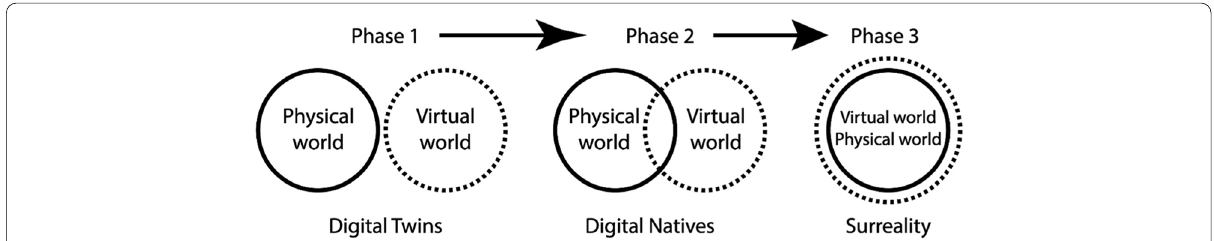
Fig. 1 The development of the metaverse can be envisioned in three phases: (1) digital twins, (2) digital natives, and (3) surrealism